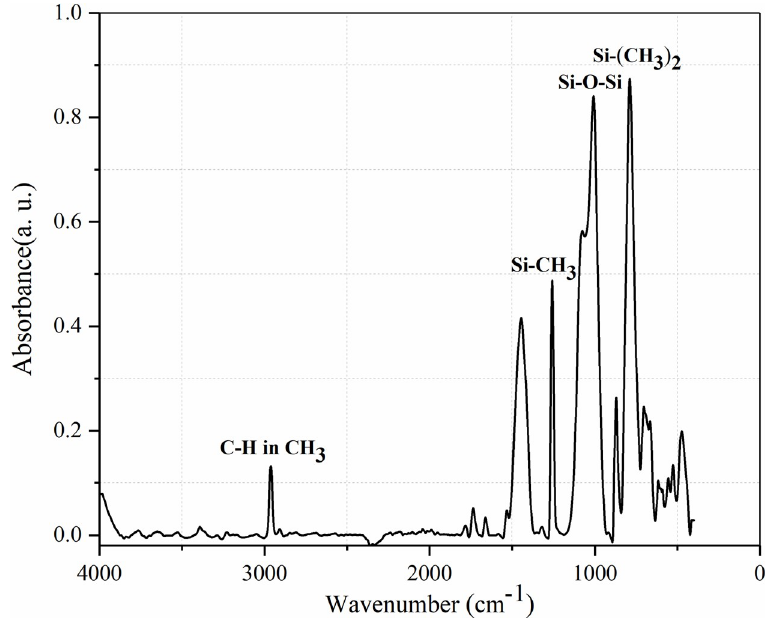
Fig 11. FTIR spectrum of distribution of main chemical groups in the RTV